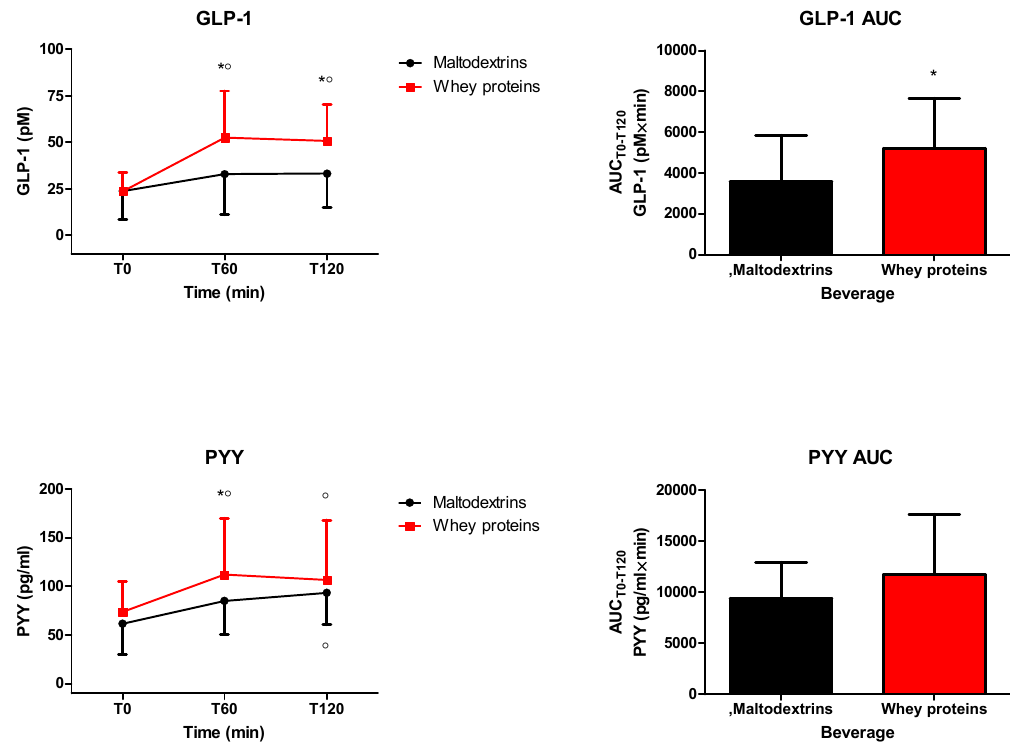
Figure 2. Changes of circulating levels of glucagon-like peptide 1 (GLP-1) (top panel) and peptide tyrosine tyrosine (PYY) (bottom panel) in obese subjects after the intake of a drink (completely within 15 min starting at T0), containing whey proteins or maltodextrins. Values (curves on the left side and areas under the curve from T0 to T120 [AUC T0 − T120 ] on the right side) are expressed as mean ± SD. The number of subjects was 8. ○ p < 0.05 vs. the corresponding T0 value; * p < 0.05 vs. the corresponding value of the maltodextrins-treated group. One- or two-way ANOVA with repeated measures (with the single factor of group, or two factors of time and group, and the interaction time × group, respectively), followed by the post hoc Tukey’s test, was used, when appropriate.